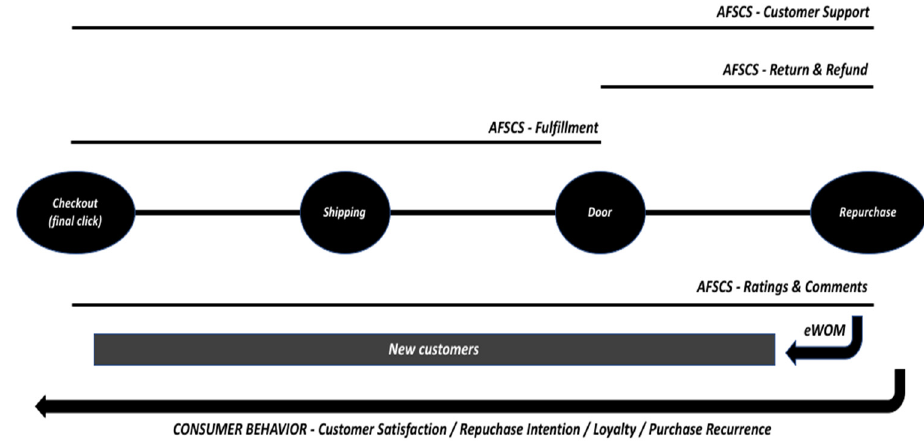
Figure 9. Framework: After-sales Customer Services at the e-commerce post-purchase stage.